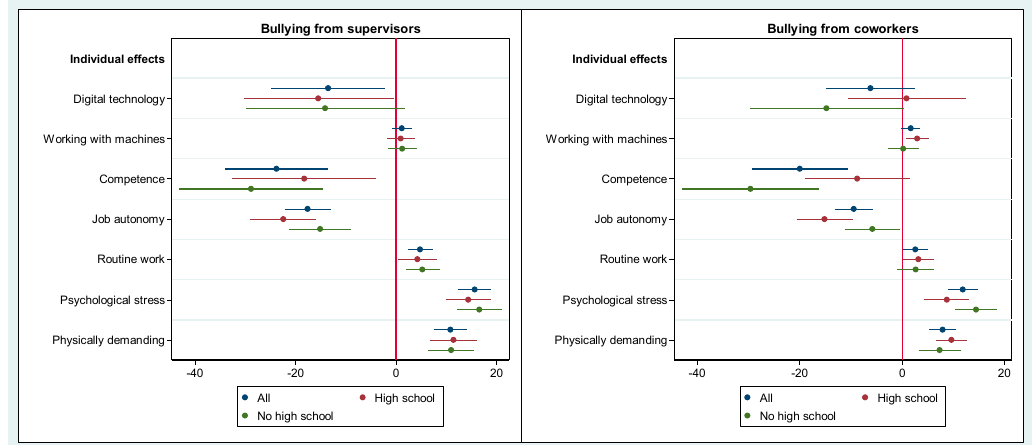
Figure 1. Coefficients estimating the influence of digitalized work and other job characteristics at the individual level on supervisory and coworker bullying with 95% confidence bands (workplace level random-effects regressions displayed in Tables 3 and 4).